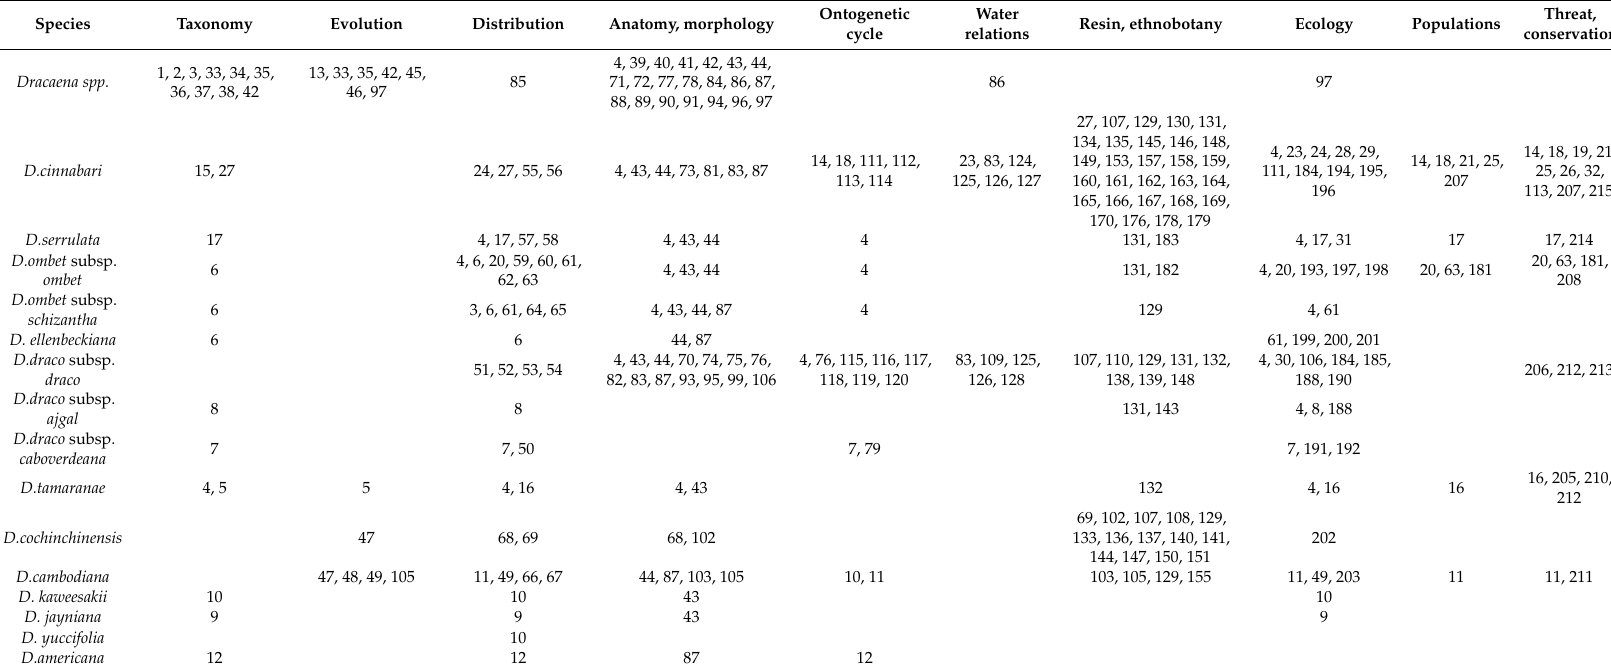
Table 3. Main characteristic of Dracaena species with the respective references Species Taxonomy Evolution Distribution Anatomy, morphology Ontogenetic cycle Water relations Resin, ethnobotany Ecology Populations Threat,